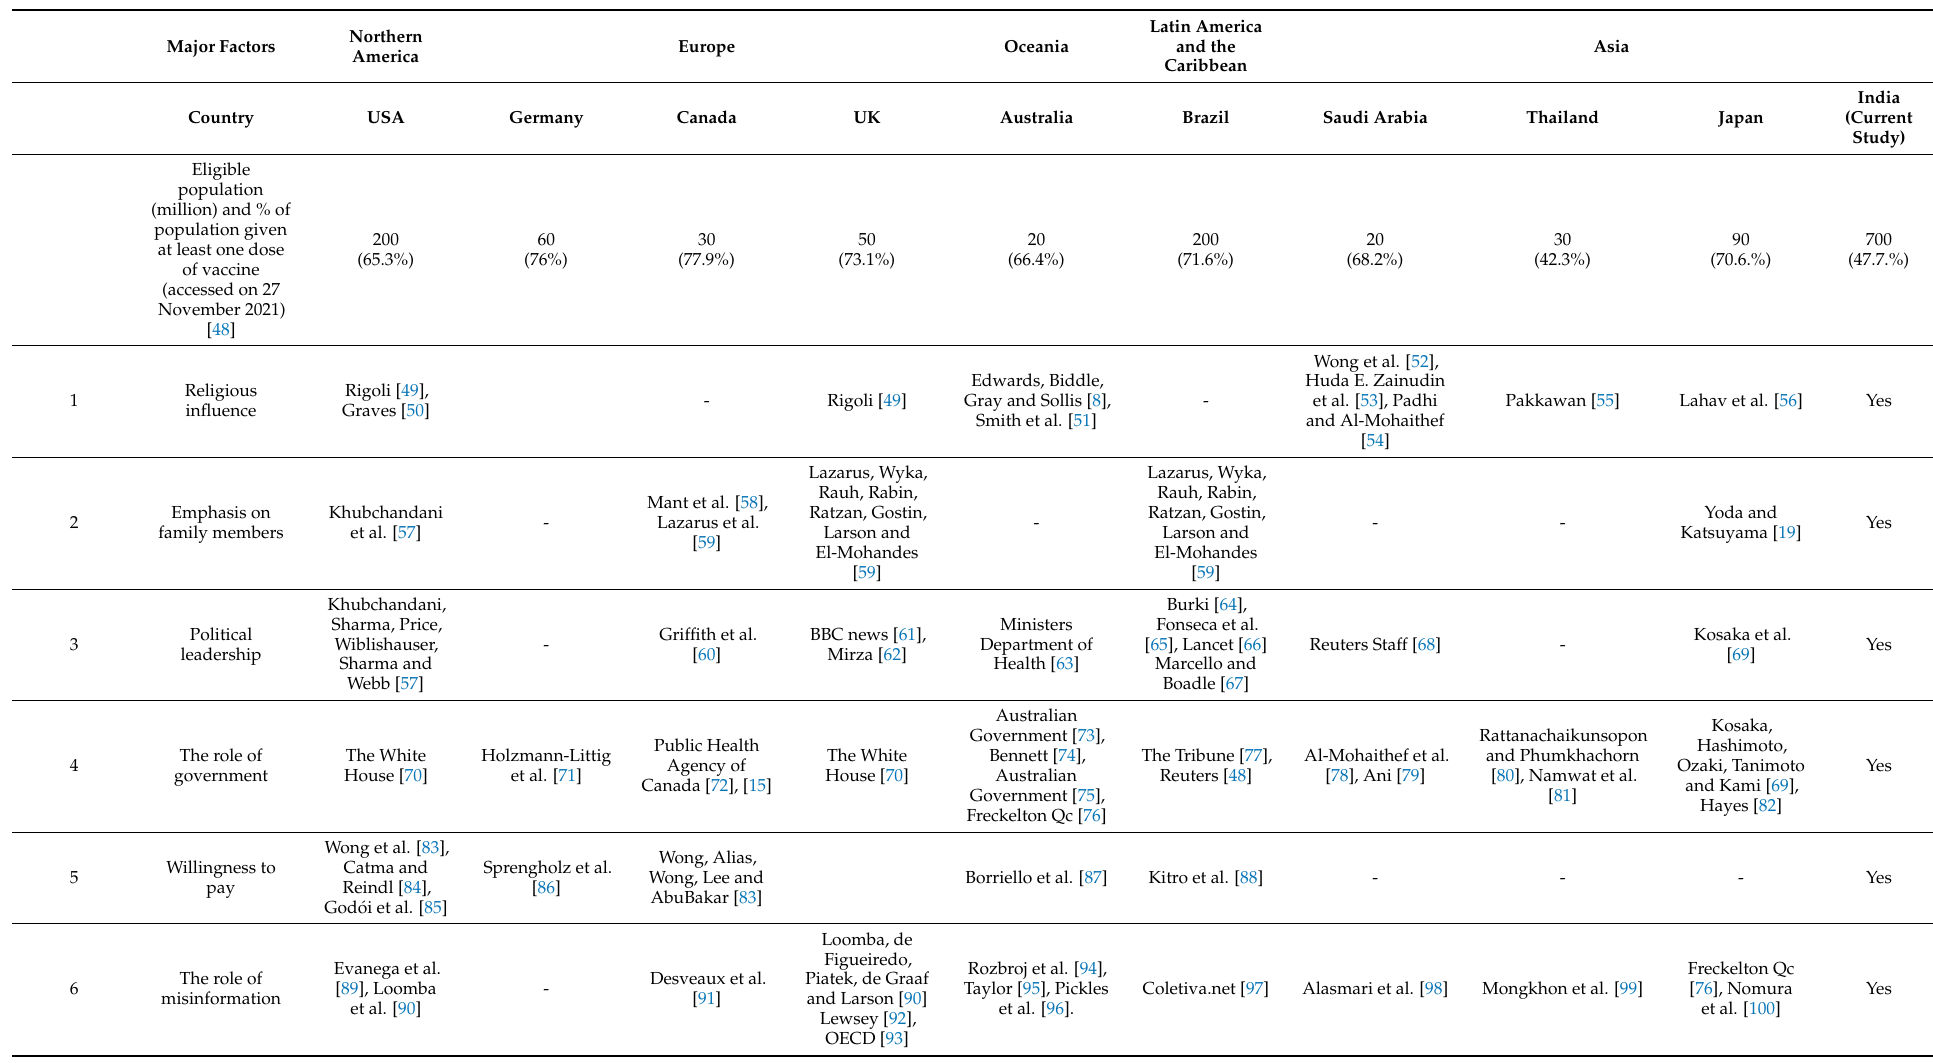
Table 2. Country-wise